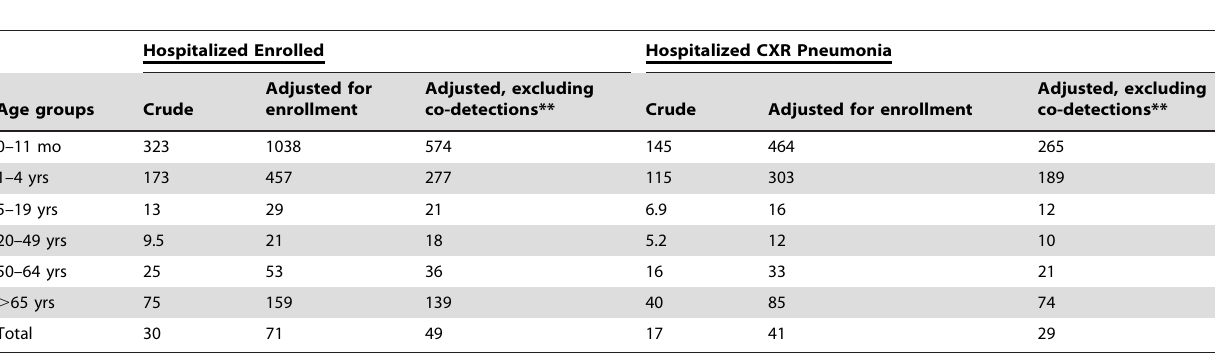
Table 2. Crude and enrollment adjusted age group specific incidence* for hospitalized HRV detections, Sa Kaeo Province, Sept 1, 2003–Aug 31,